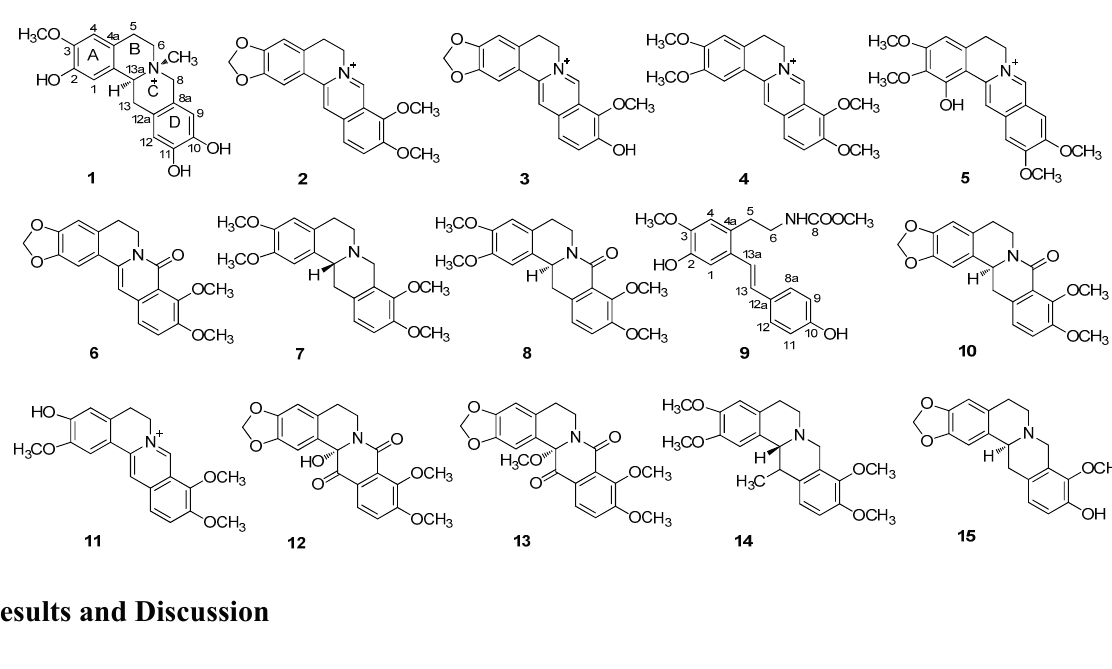
Figure 1. Structures of compounds 1 – 15